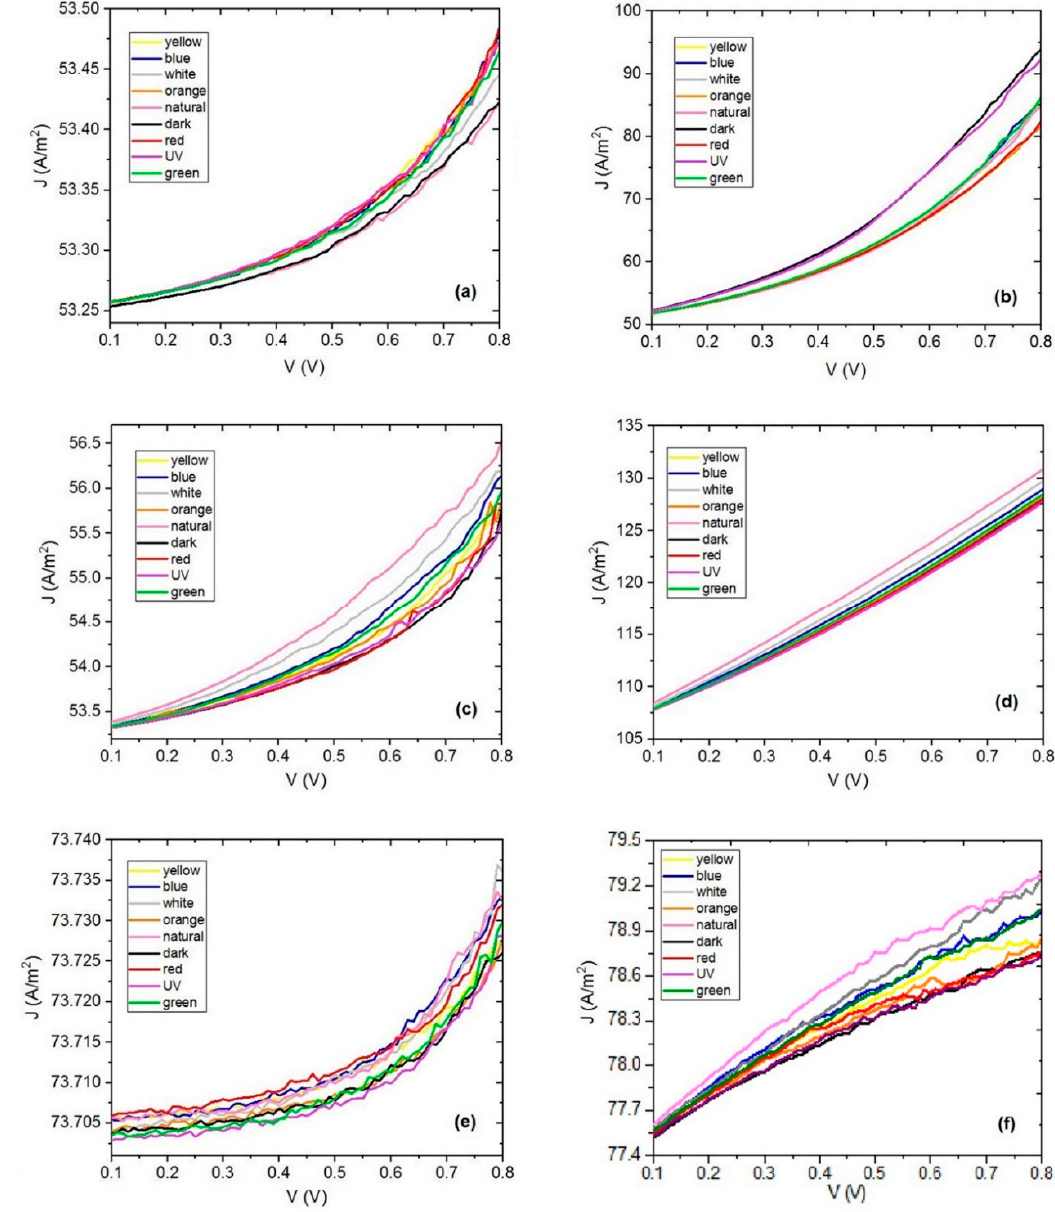
Figure 6. J - V characteristics of ( a ) D1 , ( b ) D2 , ( c ) D3 in glass and ( d ) D1 , ( e ) D2 , and ( f ) D3 in PET substrates devices.